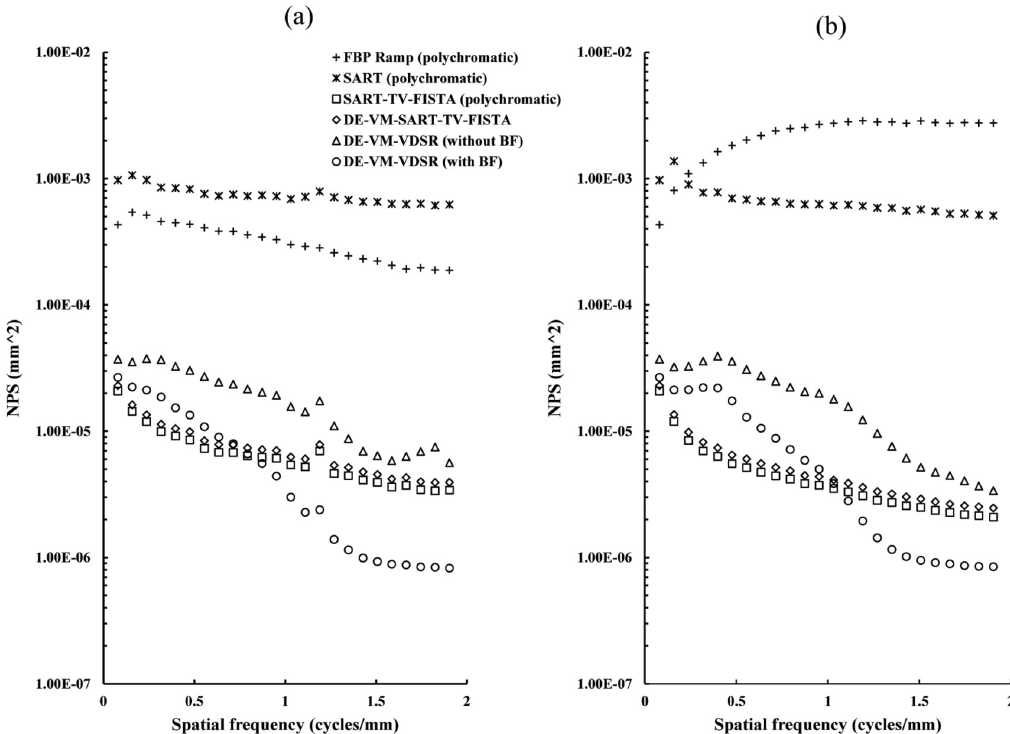
Fig 13. Plots of the Noise Power Spectrum (NPS) versus spatial frequency (cycles/mm) from the in-focus plane for the Dual-Energy (DE) Virtual Monochromatic (VM) with Very-Deep Super-Resolution (VDSR) reconstruction algorithm (DE–VM–VDSR) with and without BF and conventional reconstruction algorithms. The NPS was obtained via two- dimensional Fourier analysis of the central field of view from the reconstructed image of the uniform water phantom. (a) Horizontal directions and (b) vertical